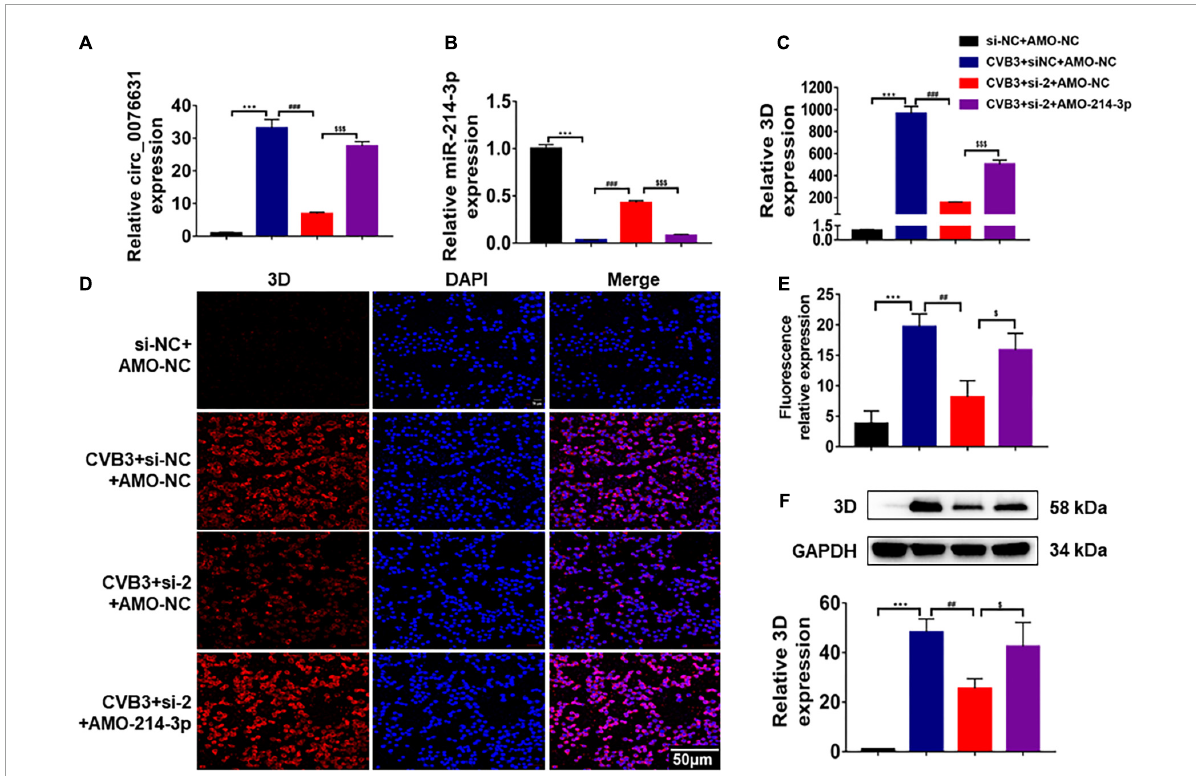
FIGURE6 Circ_0076631 knockdown suppresses CVB3 replication through miR-214-3p targeting 3D-coding sequence. (A) HeLa cells were transfected separately with si-NC + AMO-NC, si-2 + AMO-NC, and si-2 + AMO-214-3p for 24 h, and infected with CVB3 (MOI = 10) for 6 h. (A–C) The relative abundance level of circ_0076631, miR-214-3p, and CVB3 3D was detected by RT-qPCR. (D,E) Immunofluorescence staining was performed to detect the level of the CVB3 3D protein. (F) The relative level of CVB3 3D protein was detected by western blotting. n = 3. *** P < 0.001 compared with the si-NC + AMO-NC group. ## P < 0.01, ### P < 0.001 compared with the CVB3 + si-NC + AMO-NC group. $ P < 0.05, $$$ P < 0.001 compared with the CVB3 + si-2 + AMO-NC group.